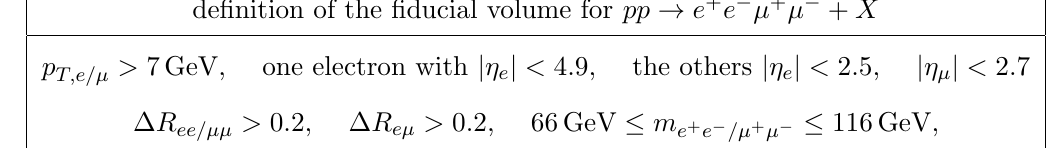
Table 2 . Phase-space de(cid:12)nitions of the ZZ measurements by ATLAS at 8 TeV [79]. contribution and its NLO corrections are always computed with NNLO PDFs. The renor- malisation and factorisation scales are set to half of the invariant mass of the four-lepton system, (cid:22) R = (cid:22) F = (cid:22) 0 (cid:17) m 4 ‘ = 2. Residual uncertainties are estimated from customary 7-point scale variations by a factor of two, with the constraint 0 : 5 (cid:20) (cid:22) R =(cid:22) F (cid:20)